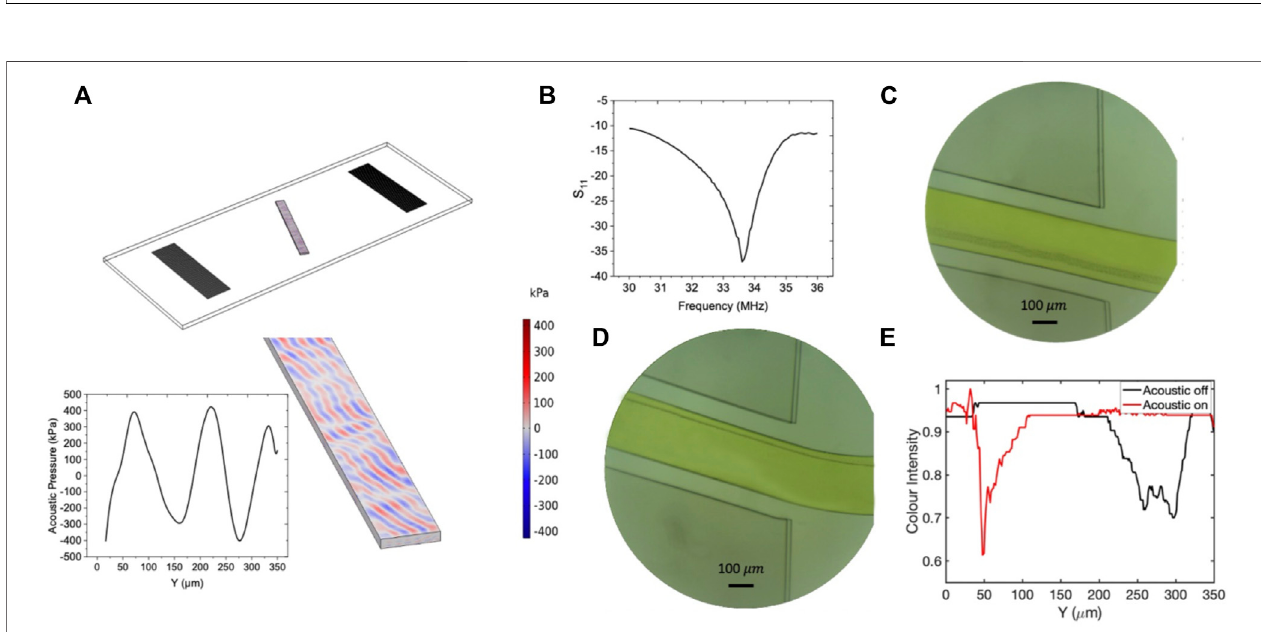
FIGURE 11 | The results of the numerical and experimental studies corresponding to experiment number 90 with tilt angle 20 ° . (A) Contours of the acoustic pressure fi elddistributioninsidethe fl uidicdomain. (B) Thefrequencyresponseoftheresonator. (C) The fl owof0 . 5 μ m particlesbeforeapplyingtheacousticforceatthe channel ’ send. (D) Con fi nementof0 . 5 μ m particlesafterapplyingtheacoustic fi eldatthechannel ’ send. (E) Graphofcomparisoncolorintensityacrossthemicrochannel before and after applying the SSAW fi eld. (The lower color intensity corresponds to darker color).